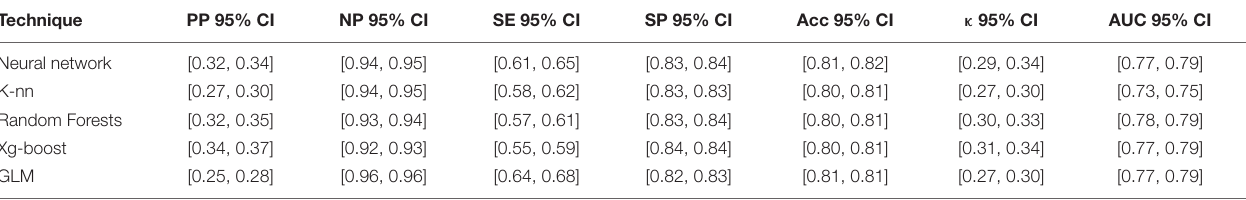
TABLE 4 | Confidence intervals of summary statistics for the predictive ability of the models built with five machine learning techniques.